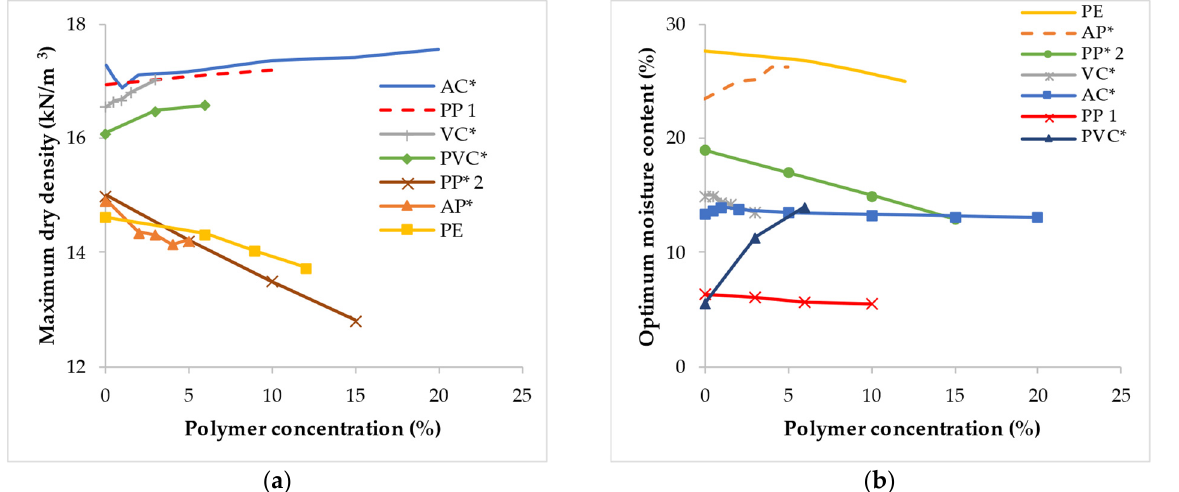
Figure 4. Variation in the compaction characteristic of fine-grain soil treated with polymer: ( a ) Maximum dry density; ( b ) Optimum moisture content (* indicates polymer concentration as a % of dry weight of soil). Note: these figures were created with data obtained from [65,109,110,136,143,149,150].